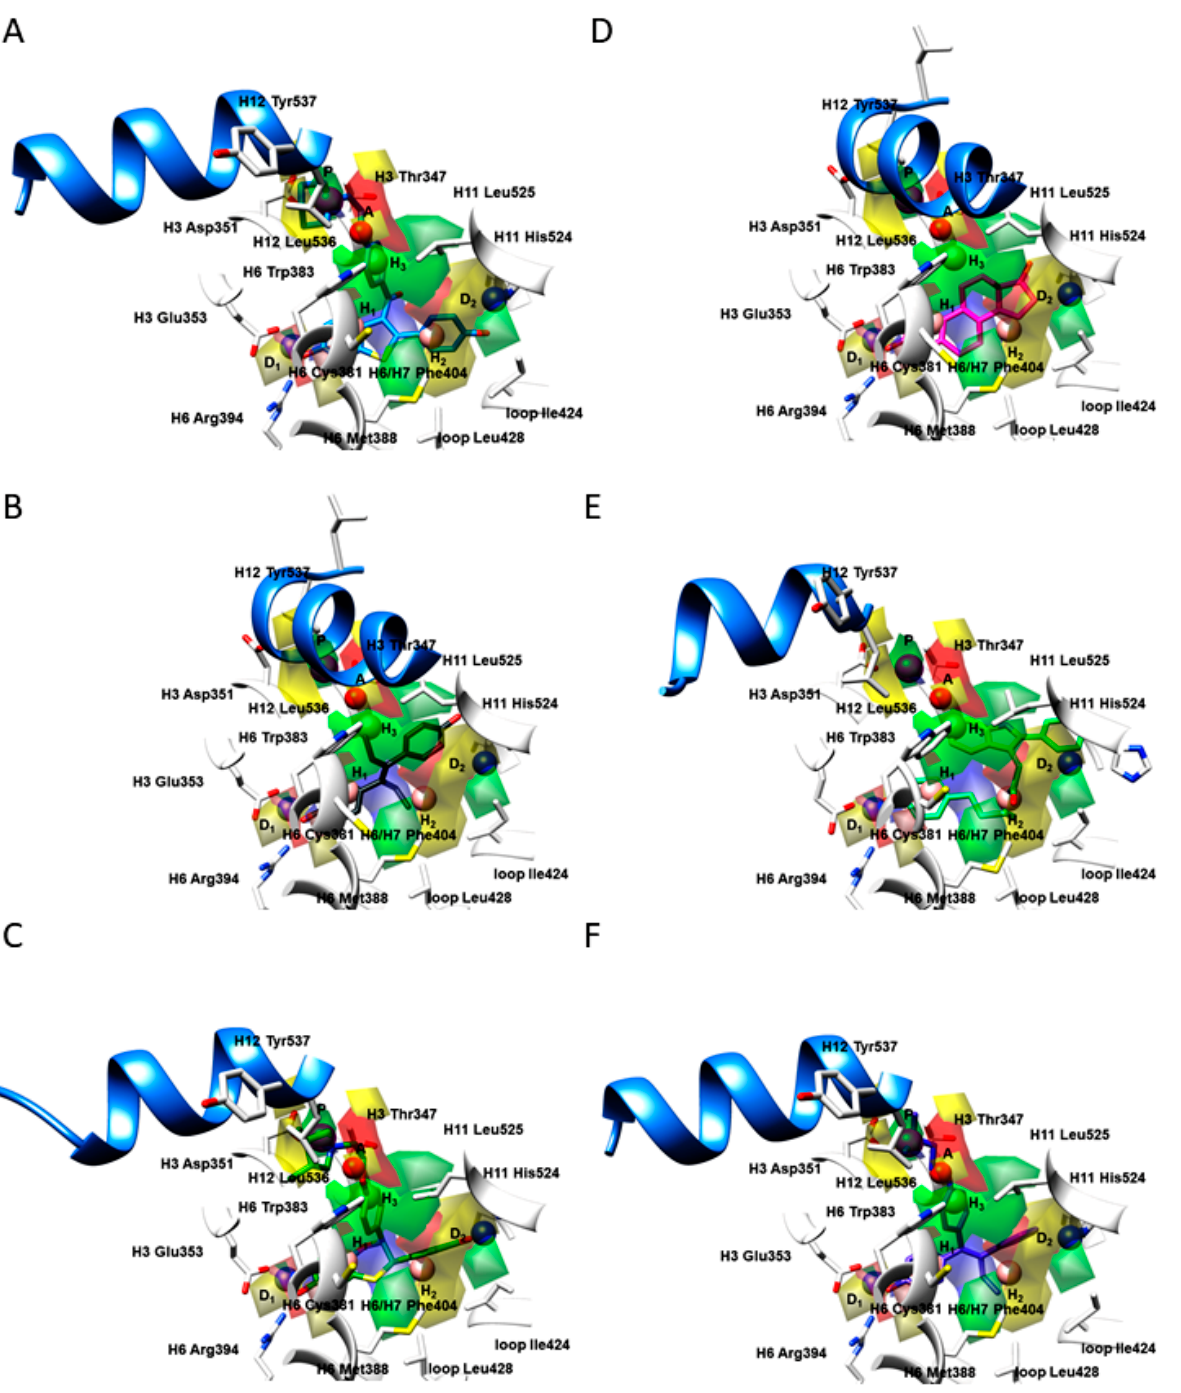
Figure 5. The 3-D PhypI features ( D : hydrogen-bond donators, A : hydrogen-bond acceptors, H : hydrophobic features, P : positive ionizable features) and 3-D QSAR PLS-coefficients contour maps ( GREEN PLS-coefficients : positive steric interactions, YELLOW PLS-coefficients ; negative steric interactions, BLUE PLS-coefficients : areas where positively charged functional groups and H-bond donators are favored whereas the negatively charged functional groups and H-bond acceptors are disfavored, RED PLS-coefficients : areas negatively charged functional groups and H-bond acceptors are favored, whereas the positively charged functional groups and H-bond donators are disfavored) for 1ERR ( A ); 3ERD ( B ); 1XP1 ( C ); 1ERE ( D ); 2IOK ( E ); 2BJ4 ( F ). Amino acid residues are depicted in white. For the clarity of presentation, only the H12 helix is presented in a cornflower blue ribbon, as a crucial delimiter for partial agonists, SERMs, and SERDs.